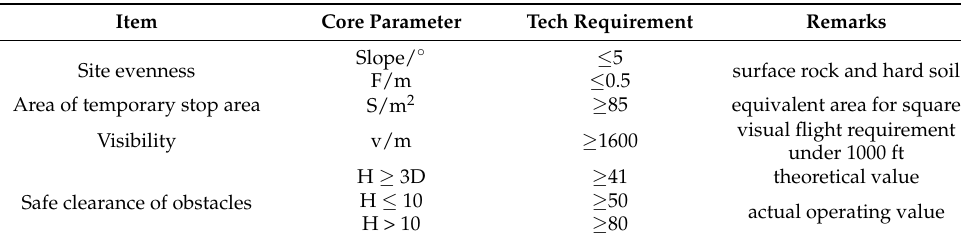
Table 1. Technical requirements for helicopter take-off and landing point.